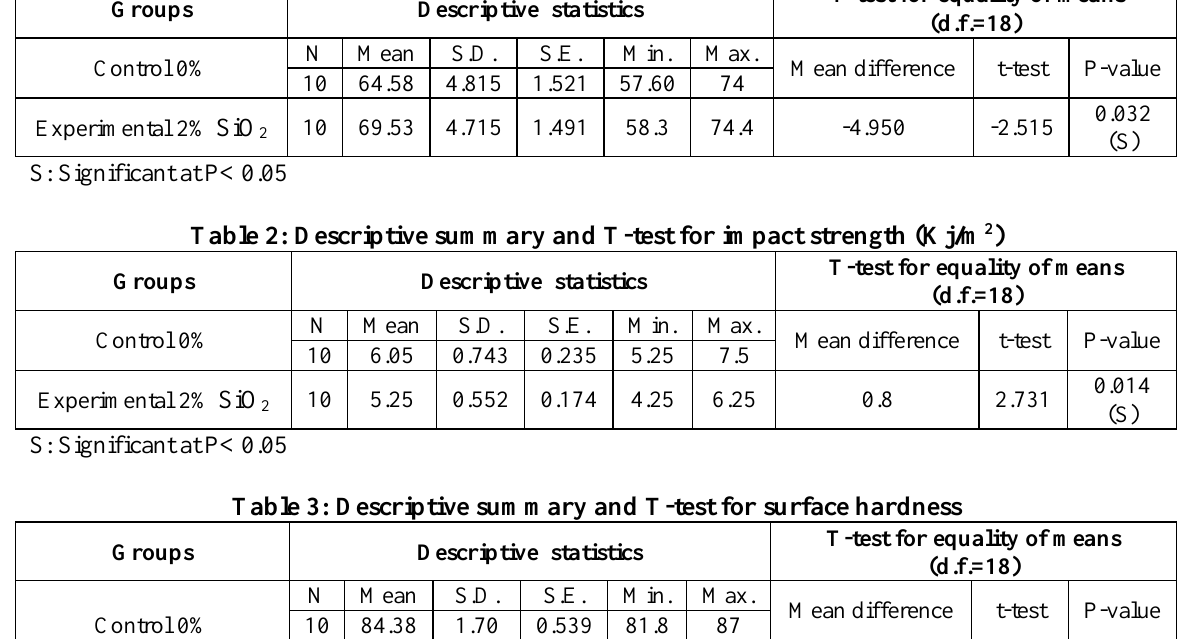
T-test for equality of means (d.f.=18)